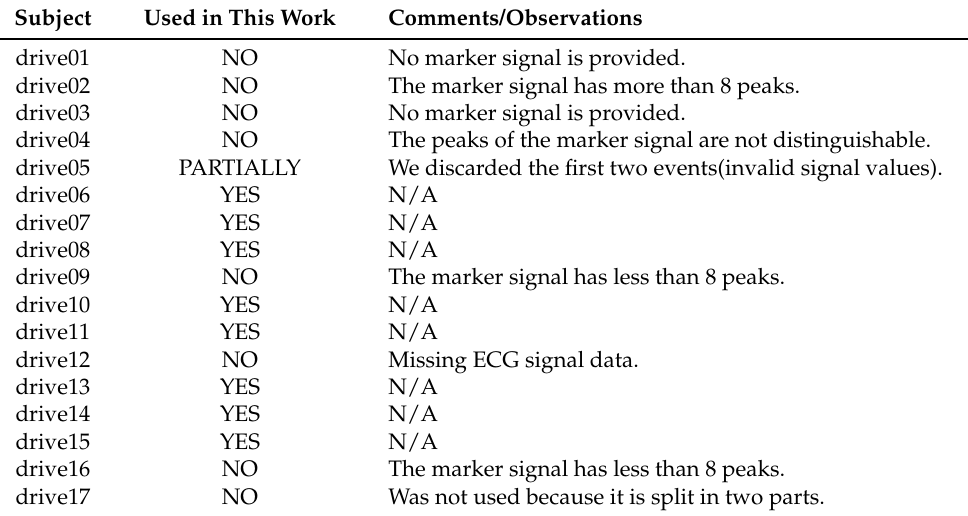
Table 1. DriveDB observations and errors.